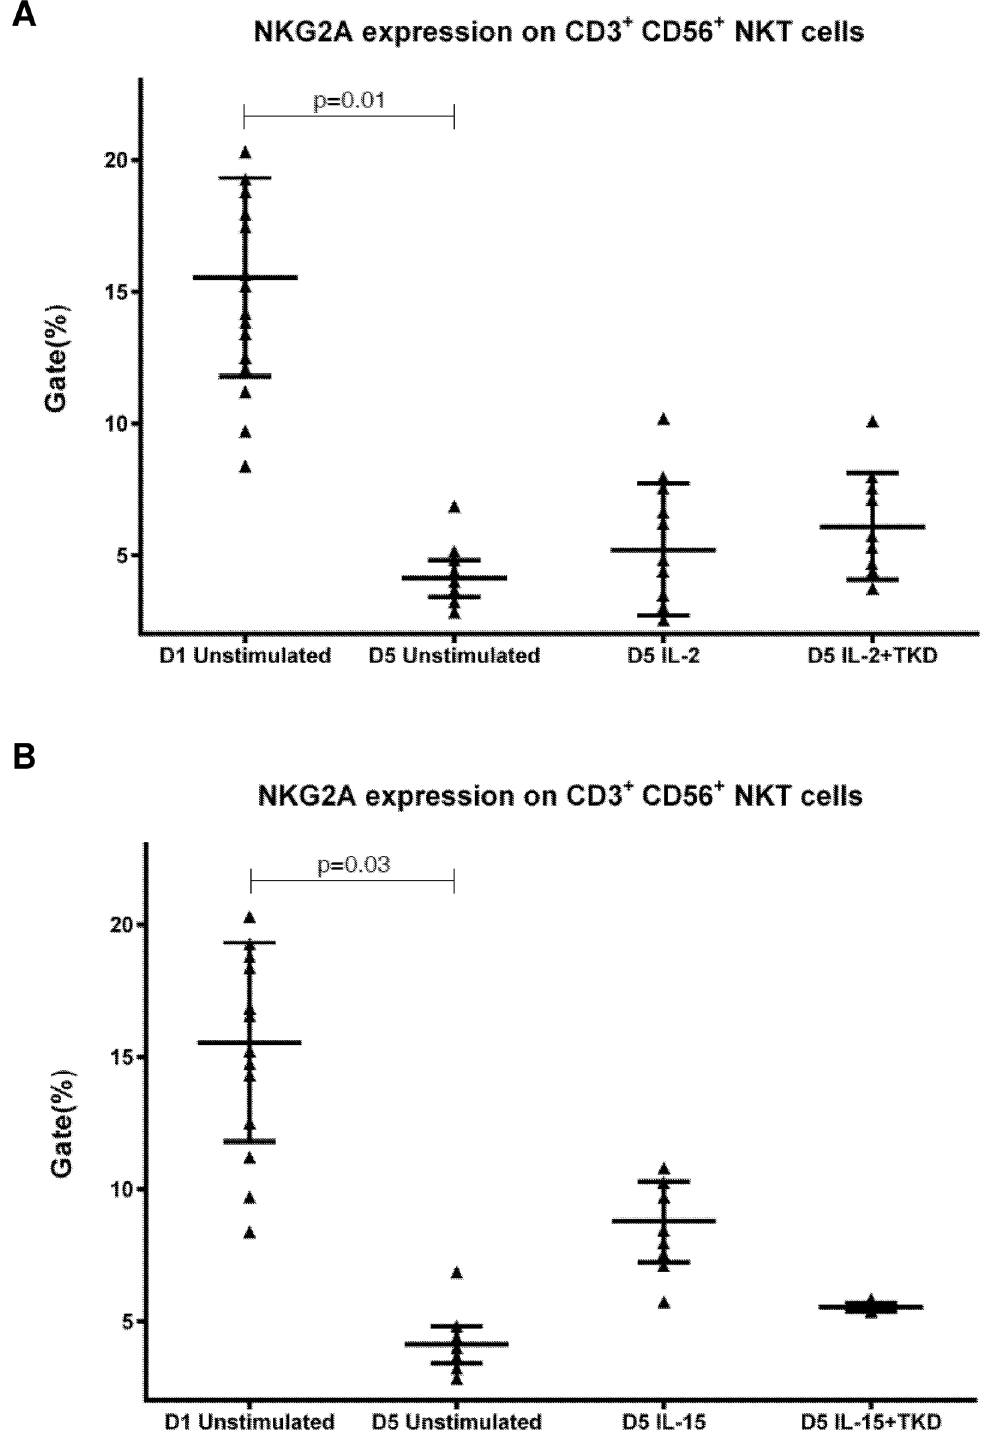
Fig 9. The effect of IL-2, IL-15, IL-2/TKD and IL-15/TKD on the expression of NKG2A receptor in peripheral blood mononuclear cells of healthy individuals — the proportion of CD3 + CD56 + NKT cells expressing an appropriate receptor. The expression of NKG2A receptor on CD3 + CD56 + NKT cells was examined within the fraction of unstimulated and stimulated mononuclear cells derived from 10 healthy individuals. Data are presented as means ± standard error. In total, the study cohort consisted of 52 Caucasian healthy individuals.